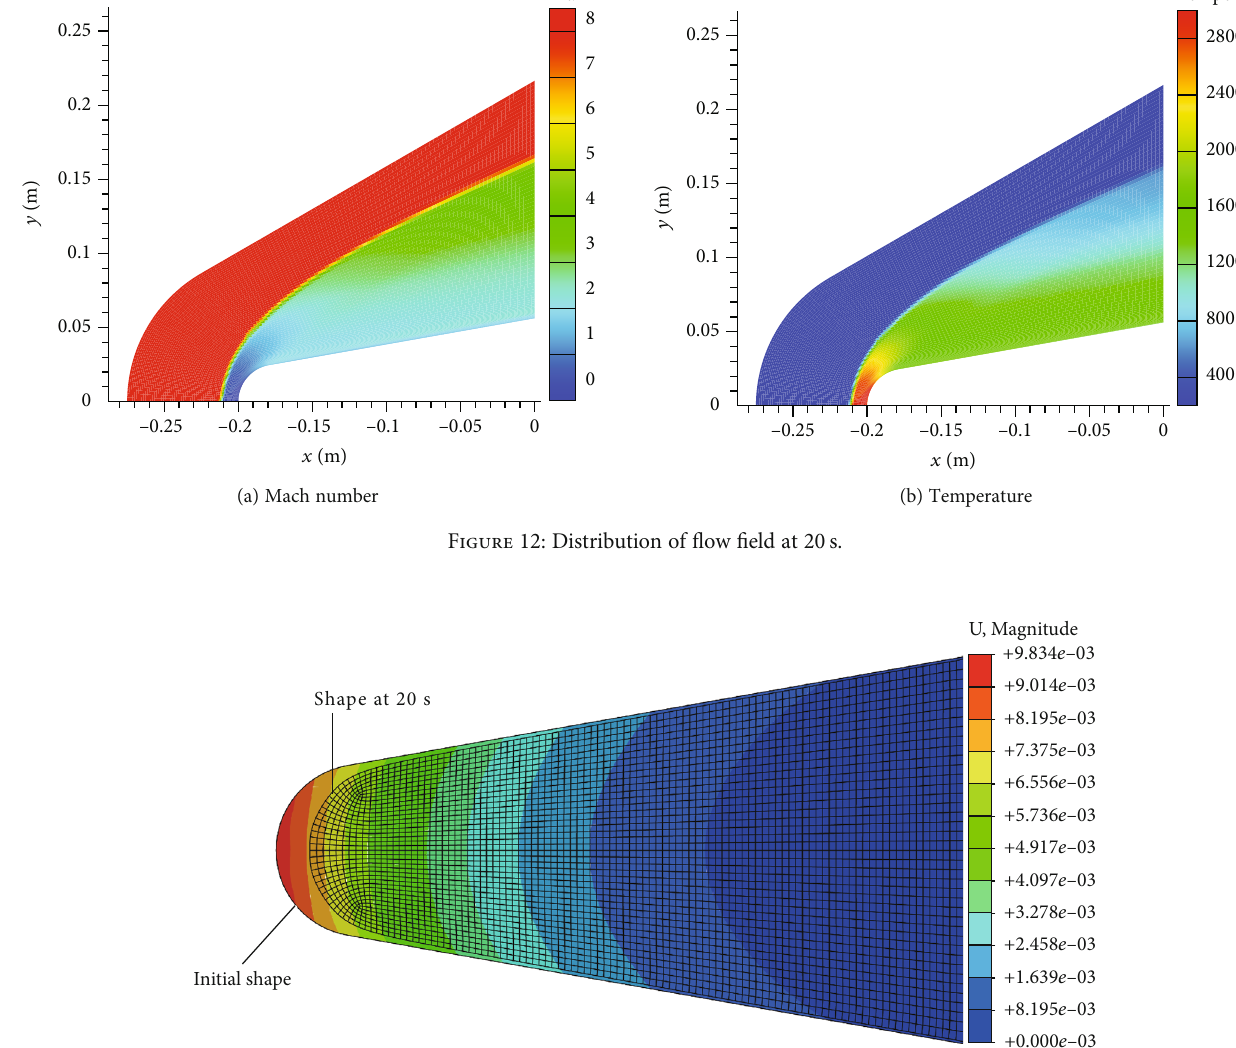
Figure 13: Ablation morphology of the leading